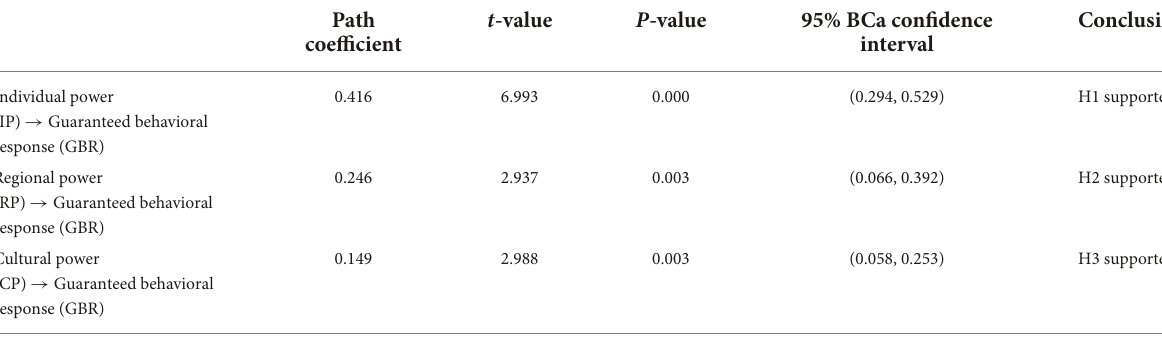
TABLE 5 Significant testing results of the structural model path